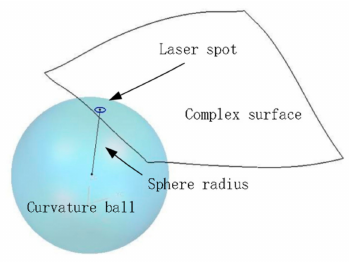
Figure 1. The curvature sphere fitting the complex